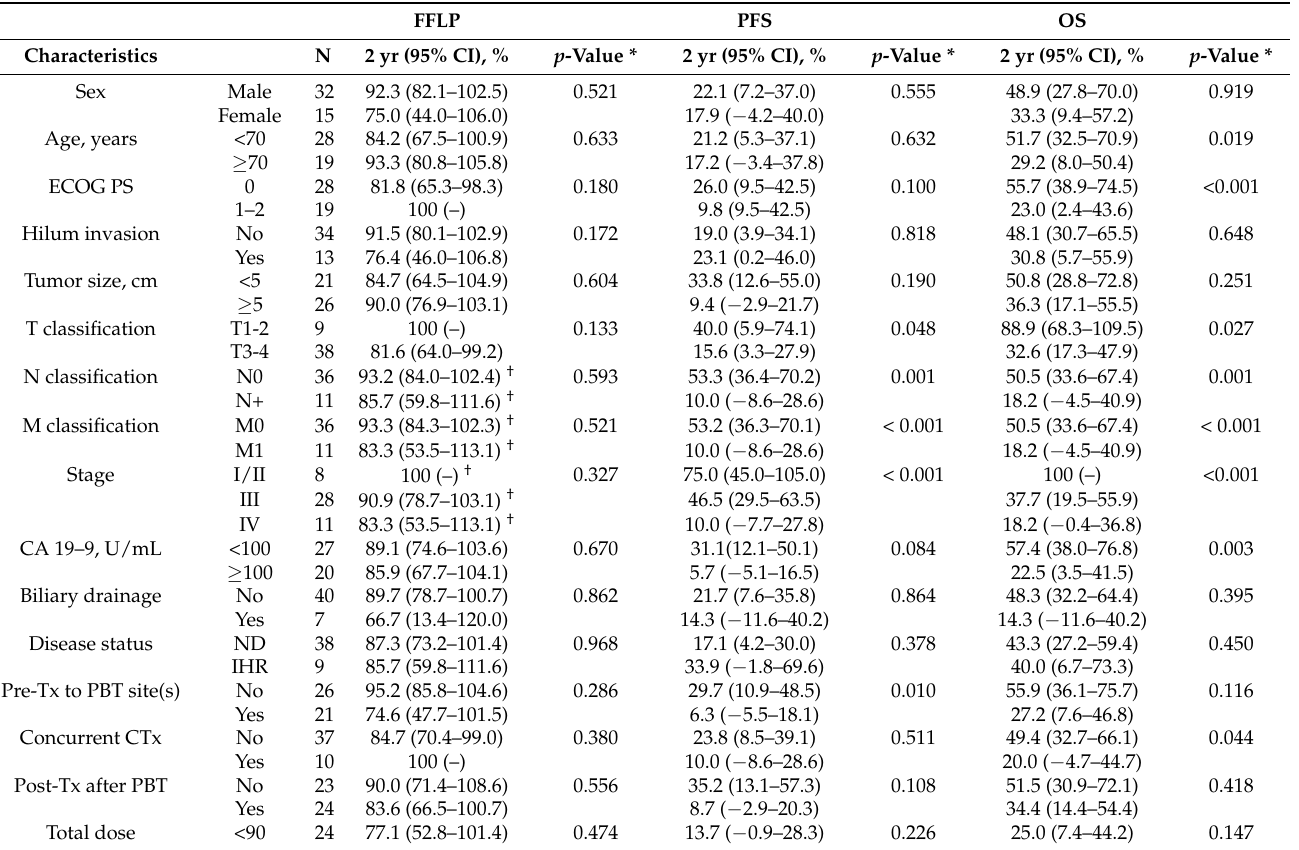
Table 2. Univariate analysis of the pre-treatment characteristics for the free from local progression (FFLP), progression-free survival (PFS), and overall survival (OS). PFS